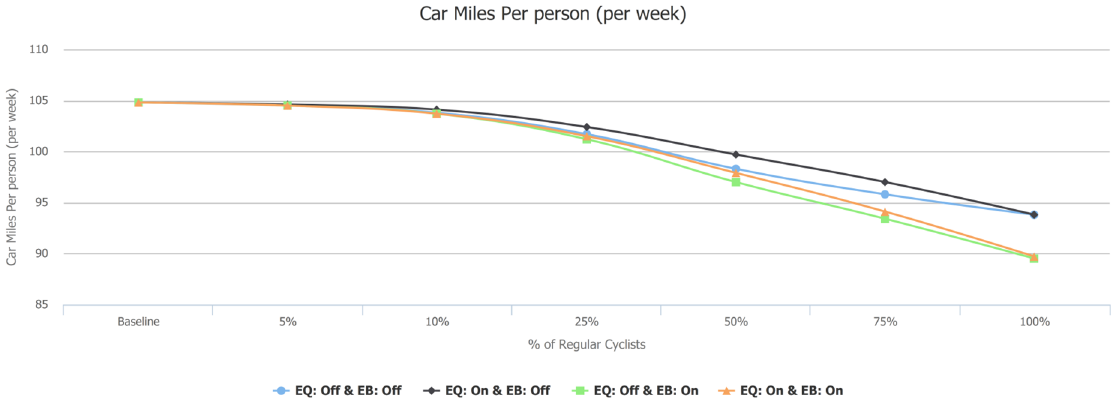
Fig 9. Car miles per person per week. EB, e-bikes scenario; EQ, equity